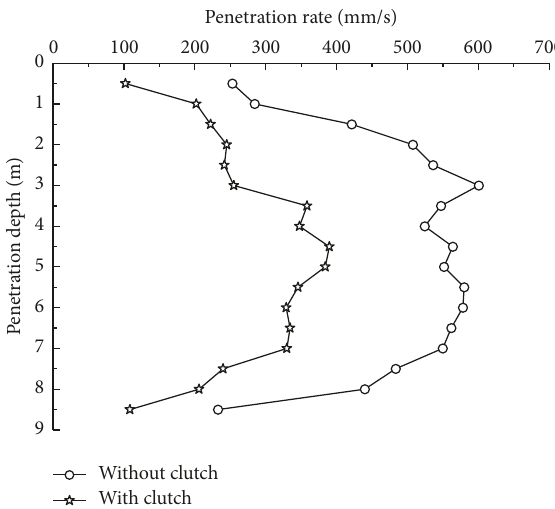
Figure 8: Penetration rate of piles with/without clutch versus penetration depth.